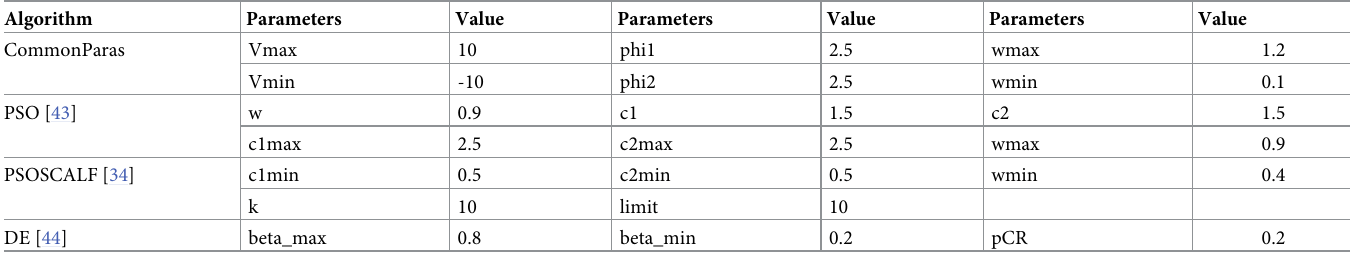
cal expression (Column 1), dimension (Column 2), search space range and initialization range (Column 3) and global optimal solution (Column 4) of the function are given in S1 Appendix. Table 2. Comparison algorithm control parameters.